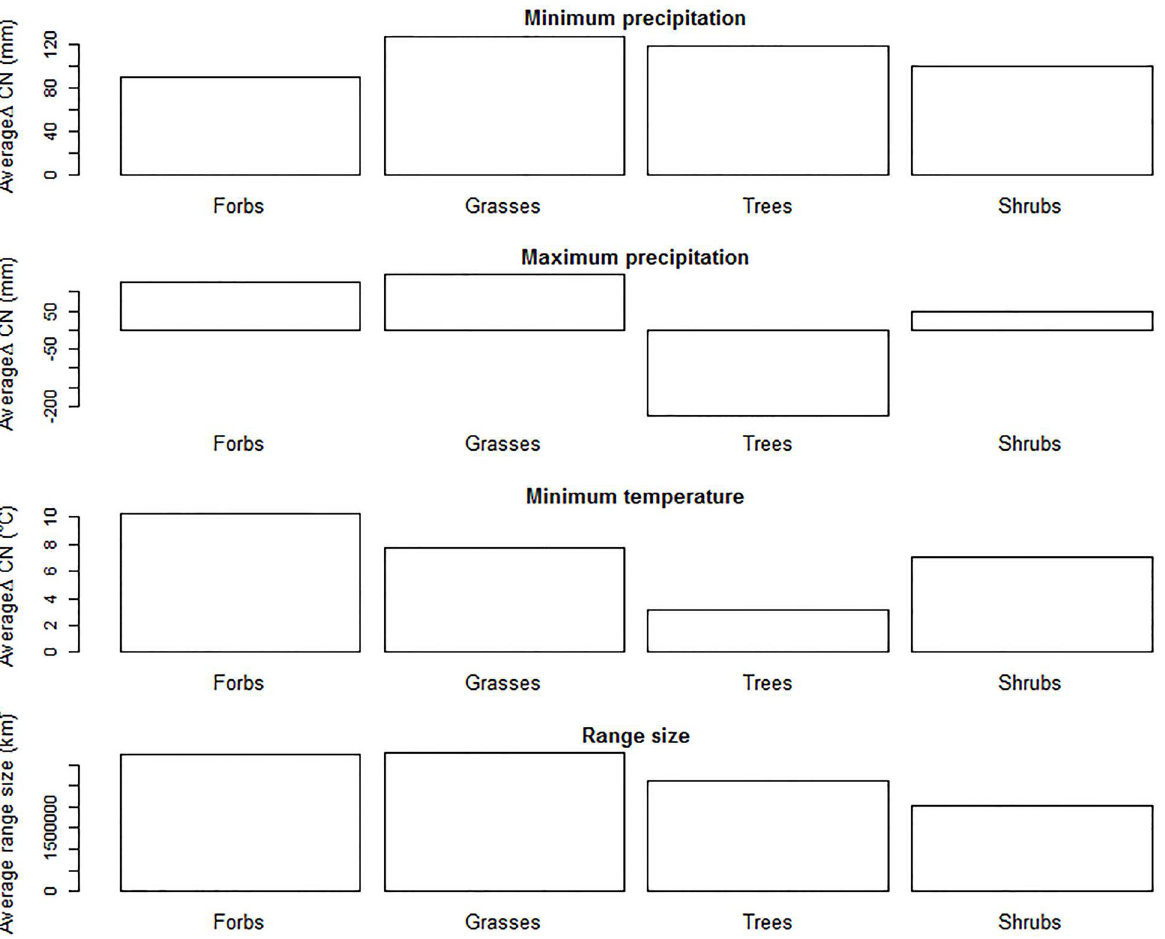
Fig 3. Difference between calculated climate niche ( Δ CN) varies by growth form. Δ CN was primarily positive (distributiondata suggested a broader tolerance than expert-based climate tolerance),but differed by growth form for all climate variables, suggesting that the effectivenessof distributiondata for identifying the climatic niche might vary with growth form. Plant growth forms had significantly different average Δ CN values for (A) minimumprecipitation,(B) maximum precipitationand (C) minimum temperature. Average range size also differed by growth form for all data